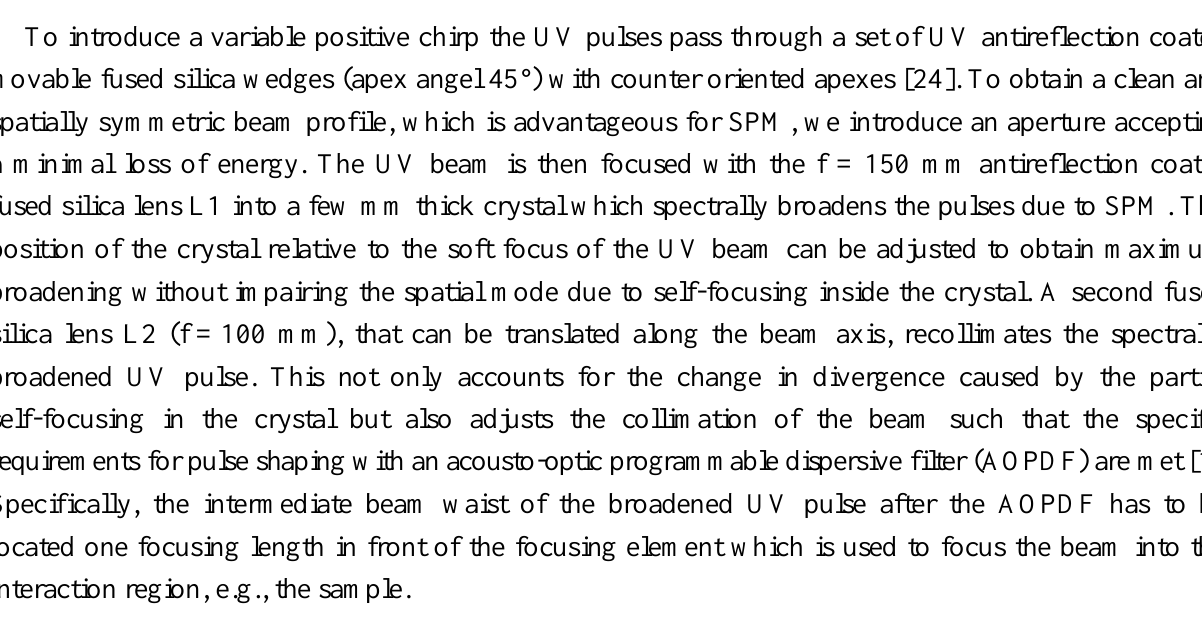
Figure 3. Setup for the generation, compression and characterization of UV pulses spectrally broadened by SPM. PC: prism compressor; SFM (SHG): sum frequency (second harmonic) generation; FS-W: Fused silica wedges; Ap: aperture; L1, L2